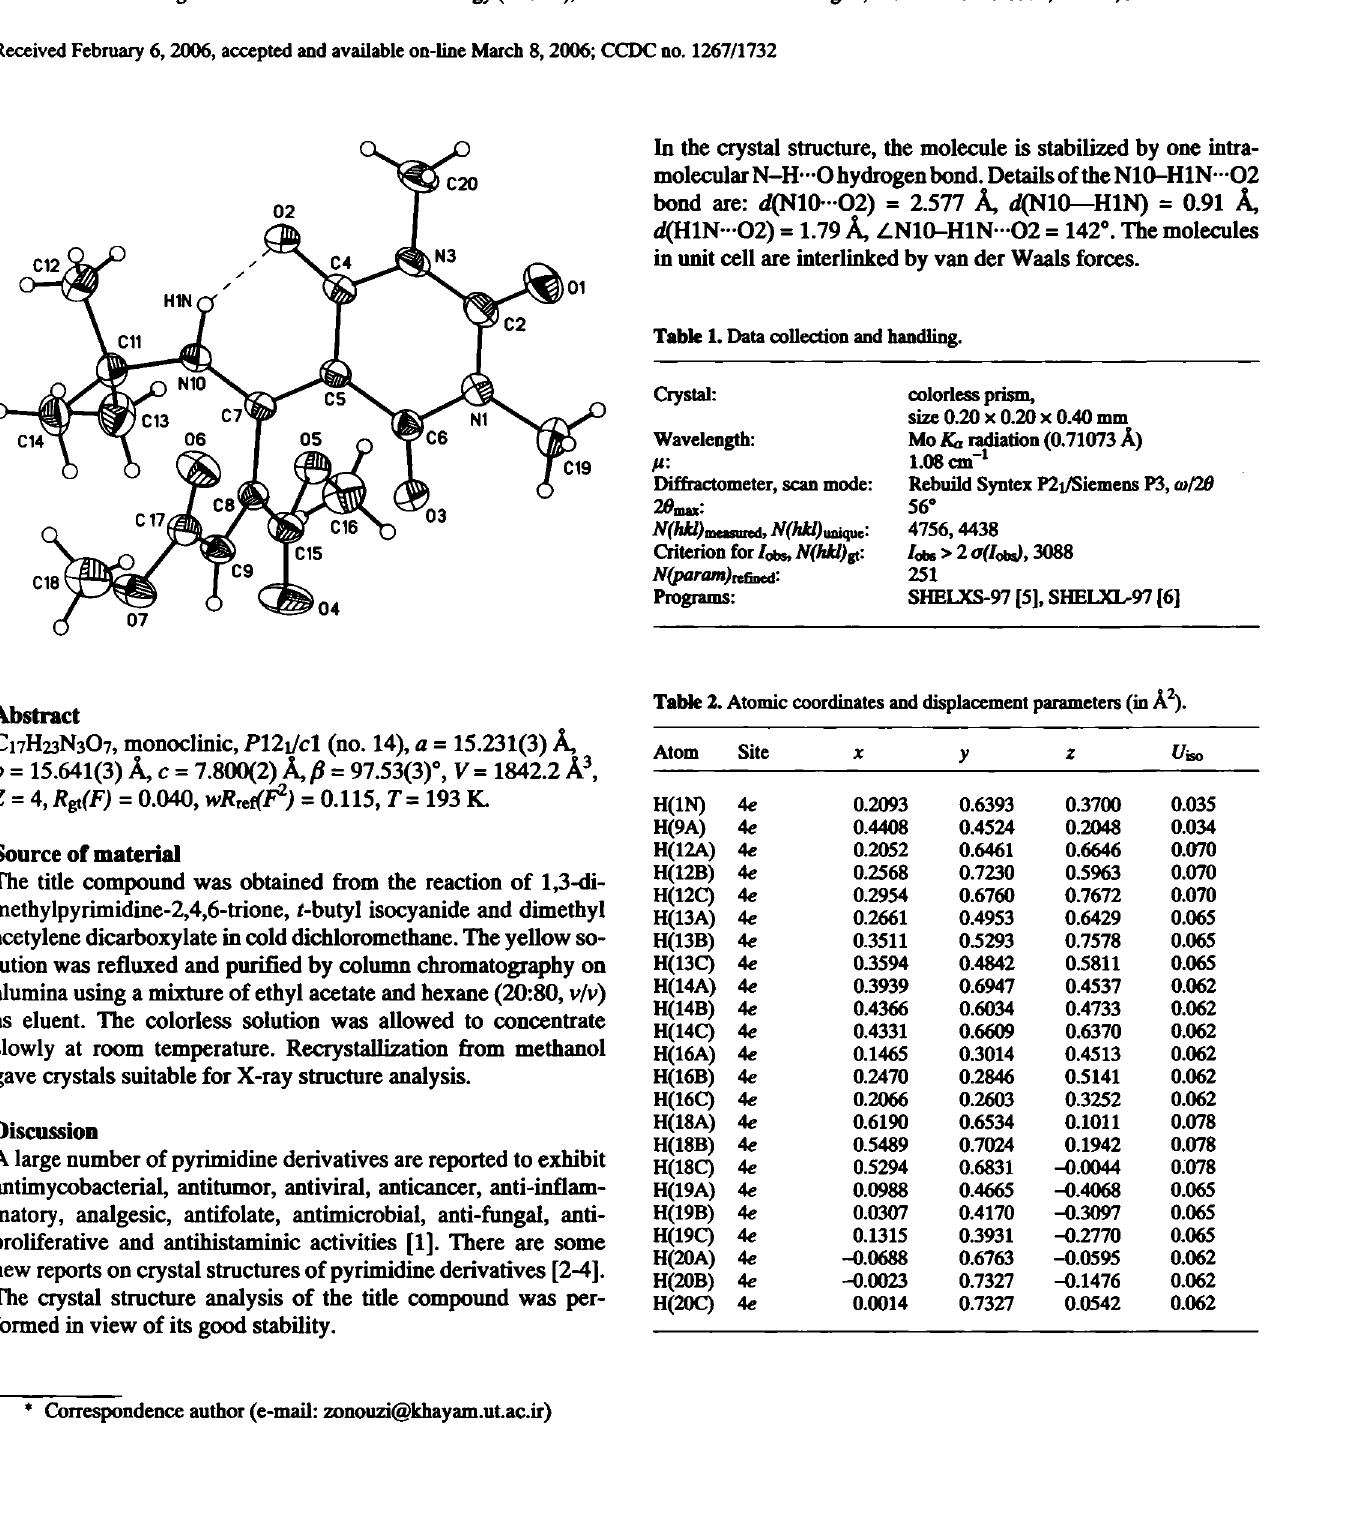
Table 1. Data collection and handling.